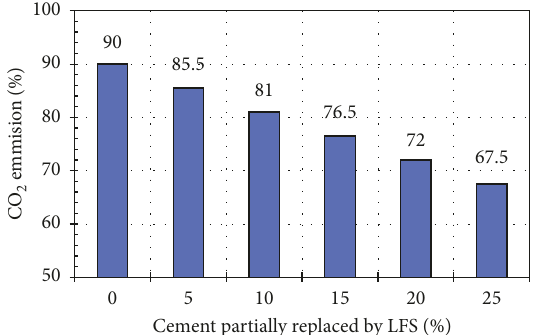
Figure 15: Probable reduction in CO